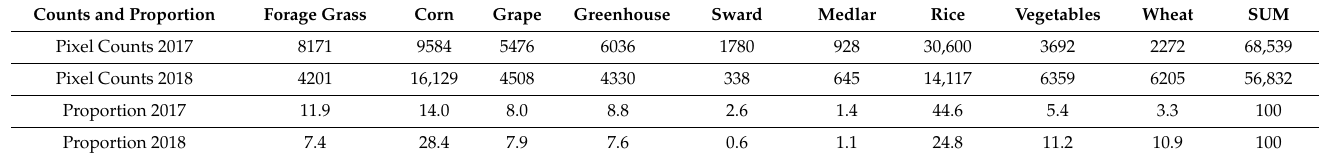
Table 1. The number of training samples for GF-1 at 15 m and the proportion for each crop type.